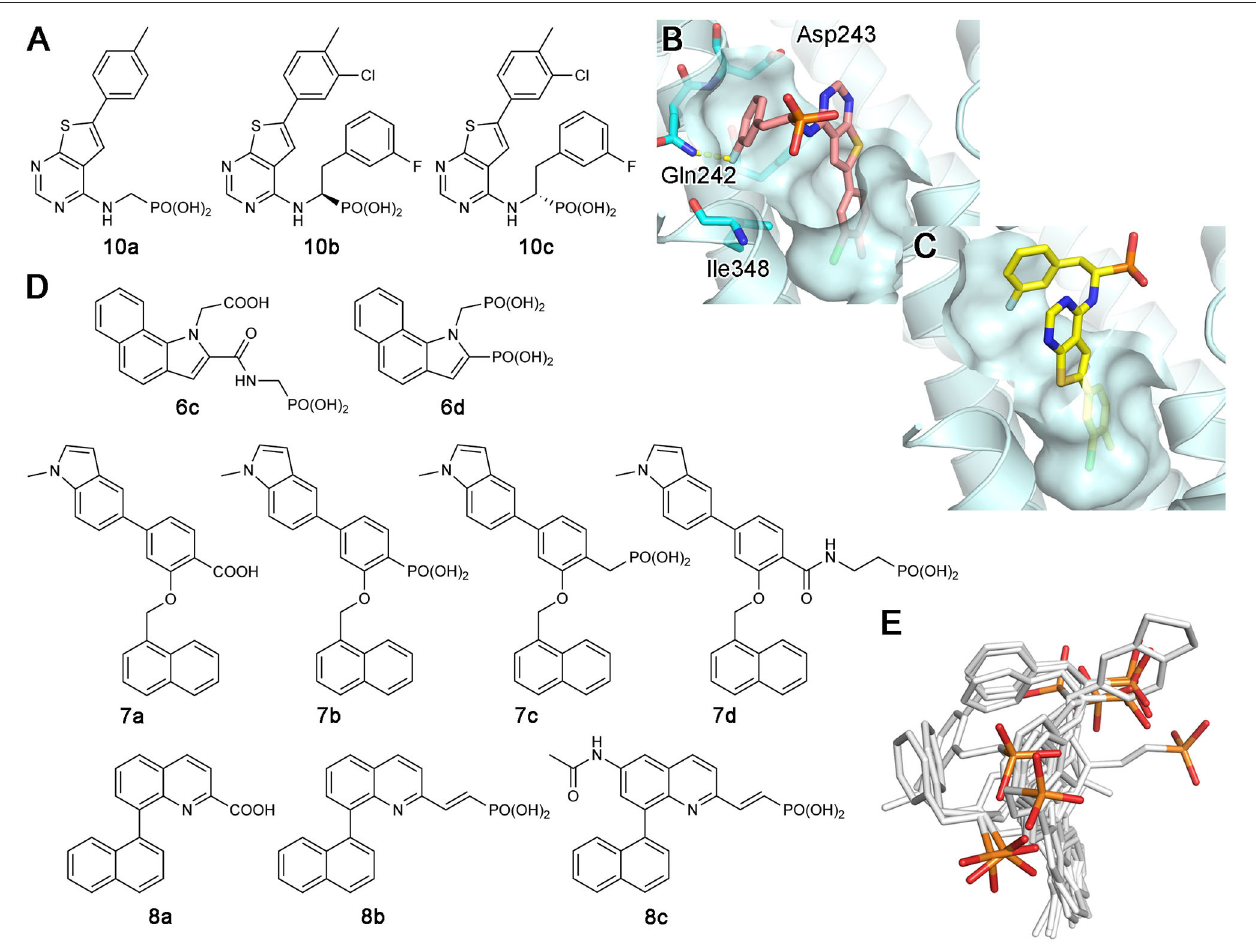
FIGURE 9 | Examples and binding modes of allosteric inhibitors of hFPPS. (A) Thienopyrimidine-based monophosphonate inhibitors of hFPPS. (B) The binding of inhibitor 10b at the allosteric pocket (PDB ID: 6N83). (C) The binding of 10c (PDB ID: 6N82). (D) Structures of benzoindole-, salicylic acid-, and quinoline-based inhibitors of hFPPS. (E) Superimposed thienopyrimidine-, salicylic acid-, and quinoline-based monophosphonate inhibitors in their binding poses. Protein structures are omitted. The phosphorus and oxygen atoms of the phosphonate groups are colored in orange and red, respectively. All other atoms are colored in